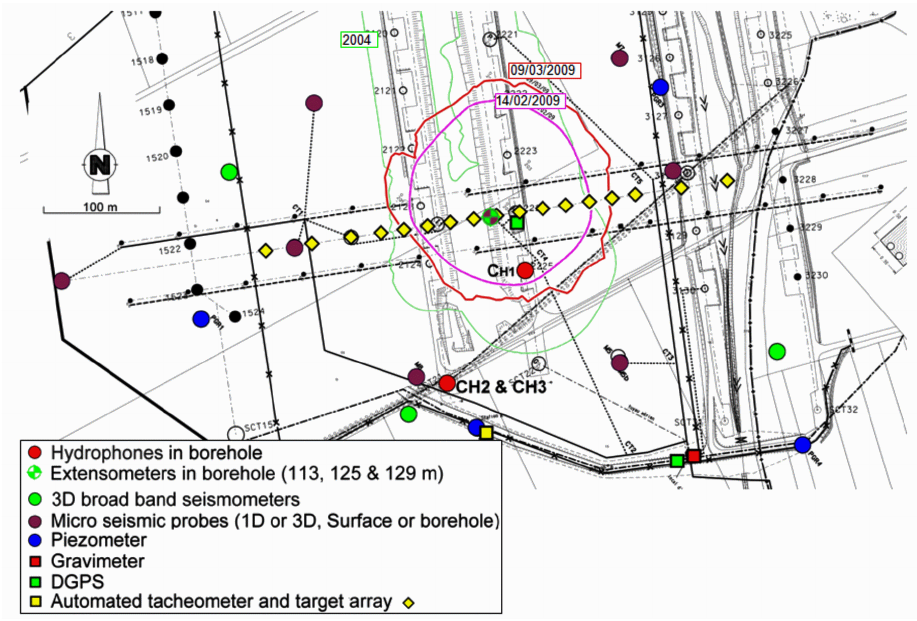
Fig. 2. Location of the hydrophone and sensor